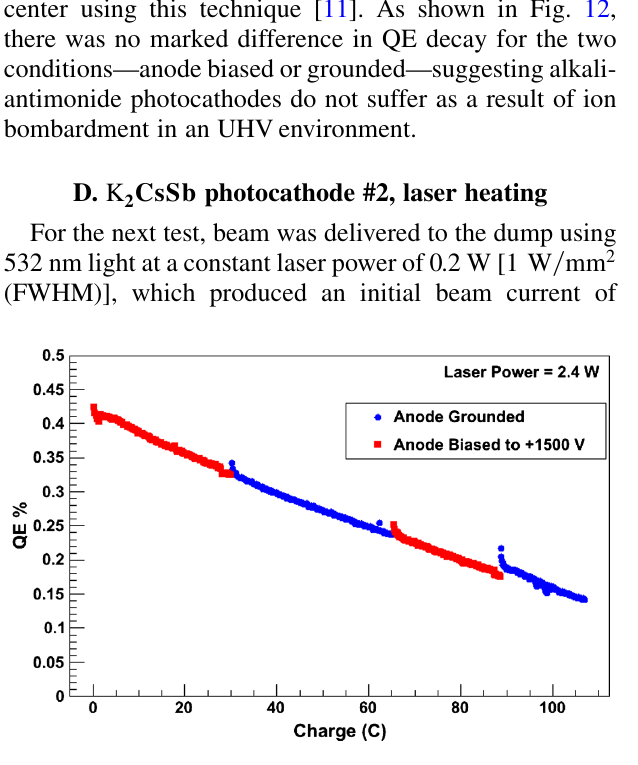
FIG. 12. The QE at the electrostatic center of K 2 CsSb photo- cathode #2 versus extracted charge at 10 mA average current, 100 kV cathode bias voltage, and with the anode biased at þ 1500 V (red) and grounded (blue)